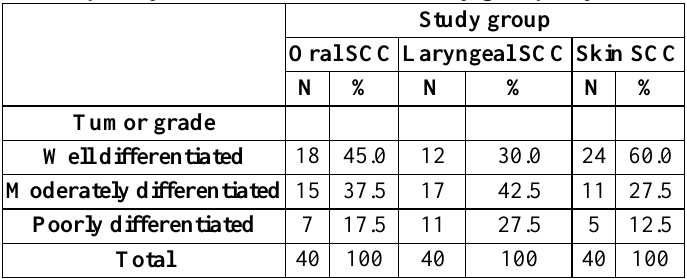
Table 2: Frequency distribution of the 3 study groups by tumor grade